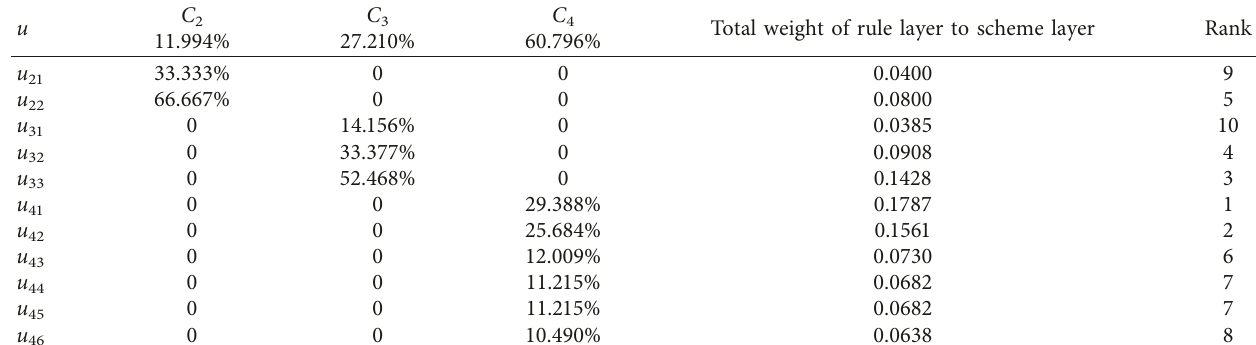
Table 14: Total rank of the evaluation index weight.